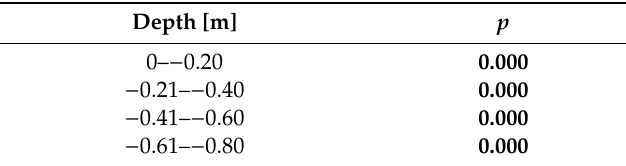
Table 15. Kruskal–Wallis test for all areas (FOR, CUT, CUT EX, SUC, REF). Significantly di ff erent areas ( p < 0.05) are indicated bold.